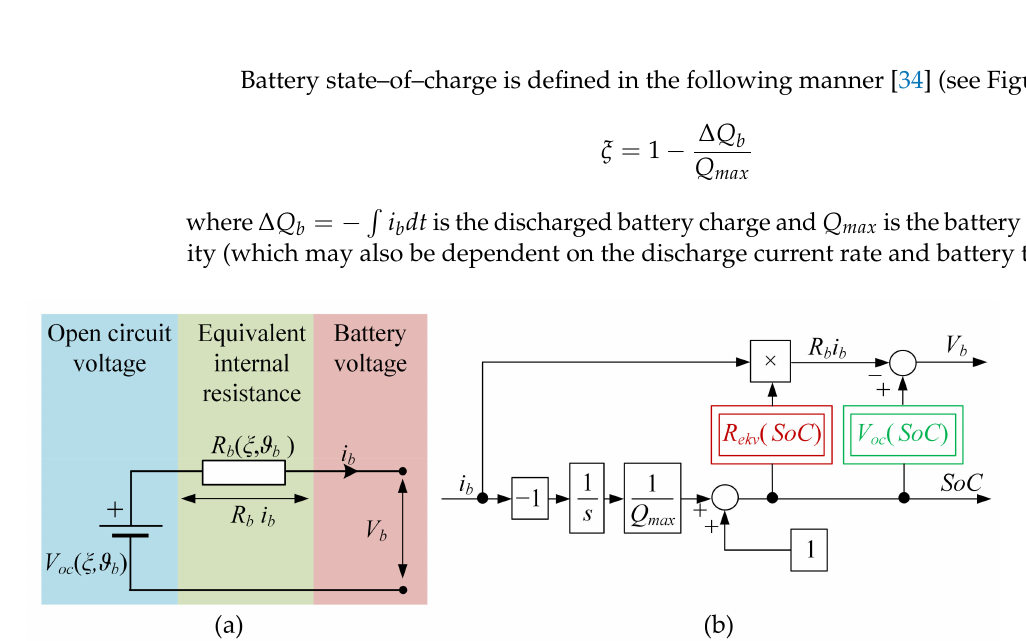
Figure 2. LiPo Battery modeling: ( a ) Quasi-static Thevenin model; ( b ) battery model block diagram realization.